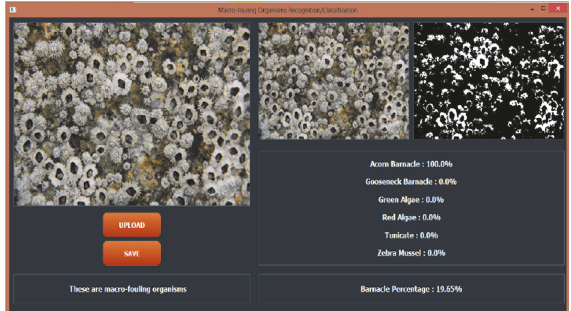
Figure 11: Proposed graphical user interface for image fouling recognition.